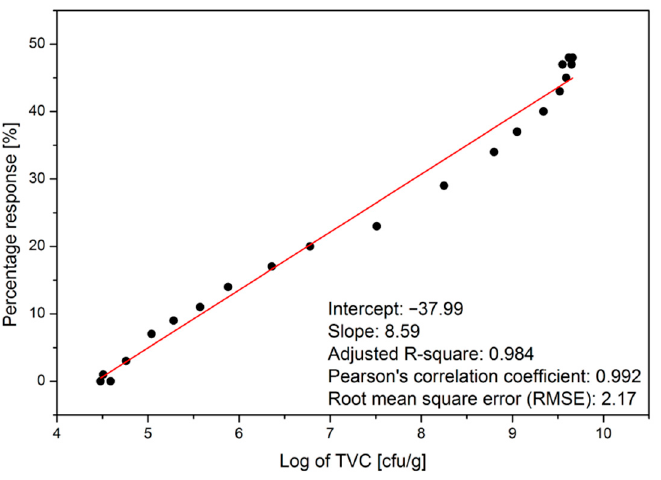
Figure 8. Correlation between the gas sensor response and the total viable count.